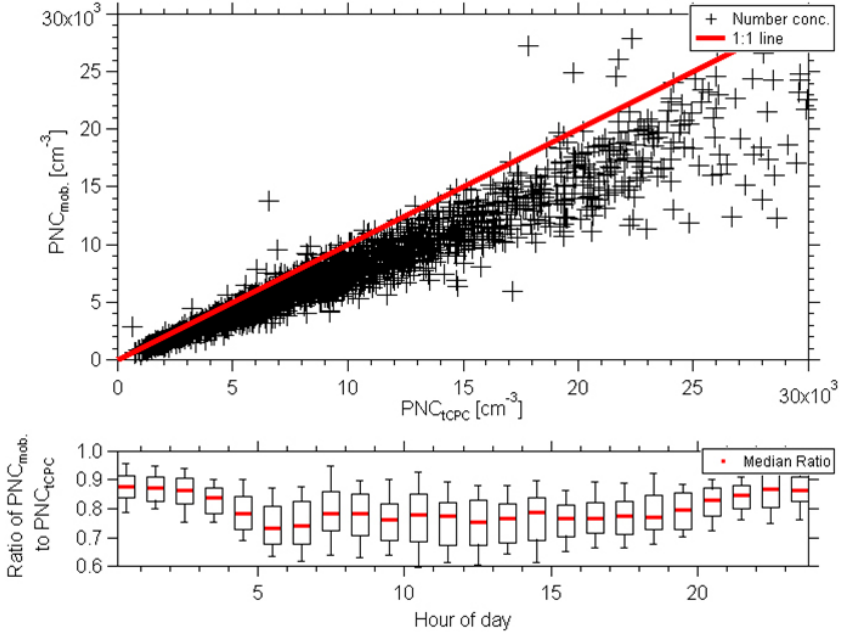
Fig. 3. Comparison of total PNCs, as measured by the mobility particle size spectrometer without diffusion screens (PNC mob . ) and the transfer CPC (PNC tCPC ) for the Annaberg-Buchholz site from 1 August 2012 to 1 August 2013. Upper graph: scatter plot of PNC mob . against PNC tCPC (black crosses). Lower graph: diurnal variation of the ratio PNC mob . /PNC tCPC .